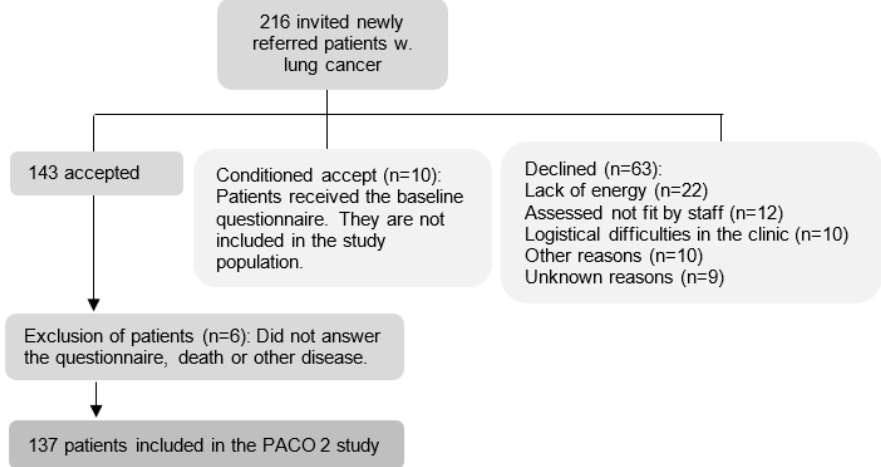
Figure 1. Flowchart for inclusion and exclusion of patients, Herlev University Hospital, Denmark, 2016–2017.